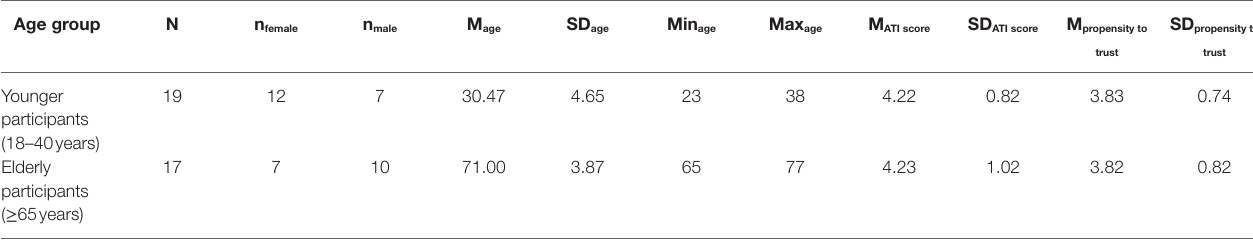
TABLE 2 | Overview of the sample characteristics.